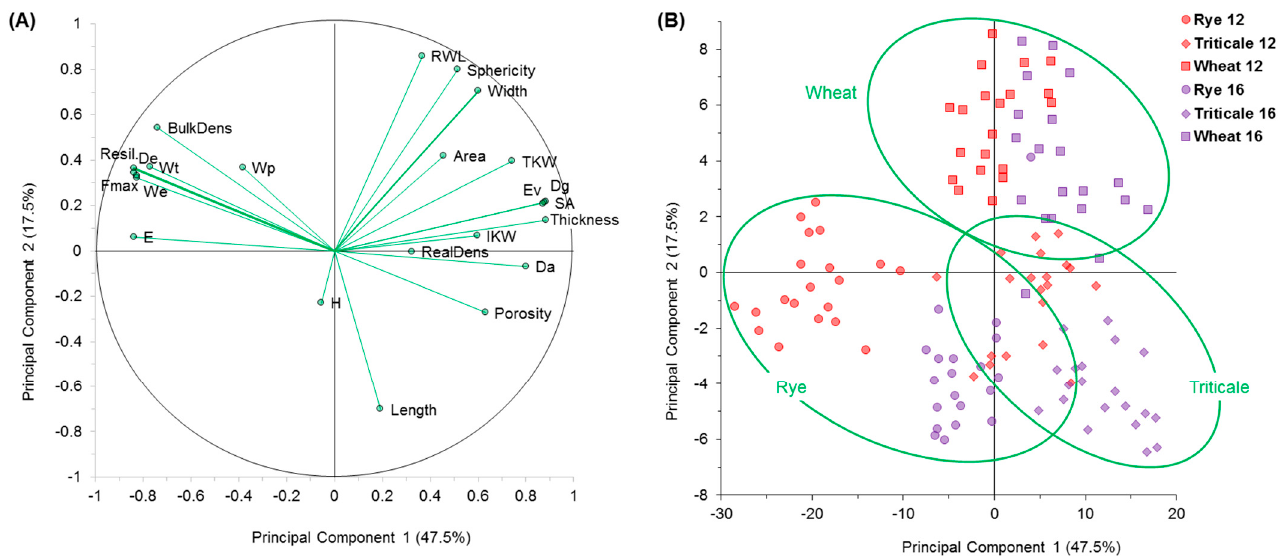
Figure 6. Principal component analysis (PCA) for the biophysical, geometric, mechanical, and viscoelastic properties of the cereal types at different moisture contents (12% and 16%). ( A ) Correlation matrix among PC1, PC2, and the evaluated variables. ( B ) Distribution of observations in the plane corresponding to PC1 and PC2 showing the distinction among cereals and moisture